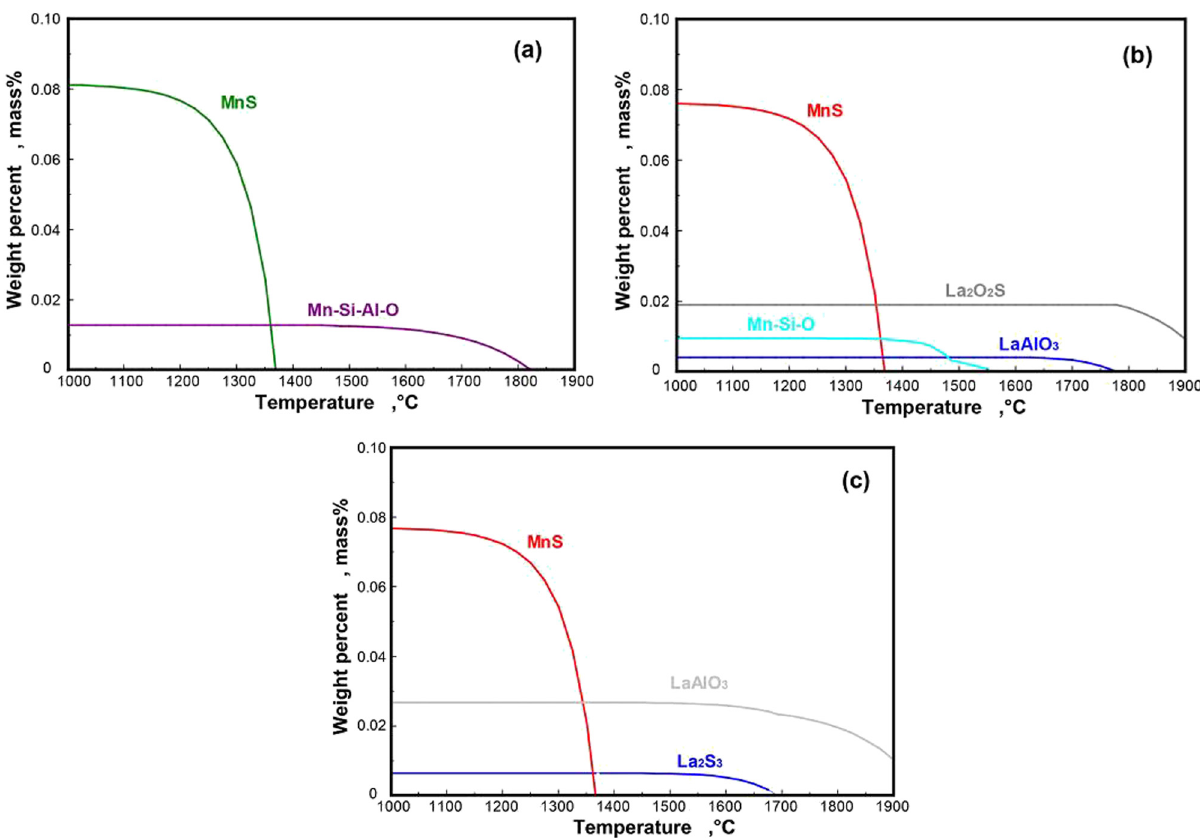
Figure 7: Calculated composition of the inclusions in steels. ( a ) Steel no. 1, ( b ) steel no. 2, and ( c ) steel no. 3.